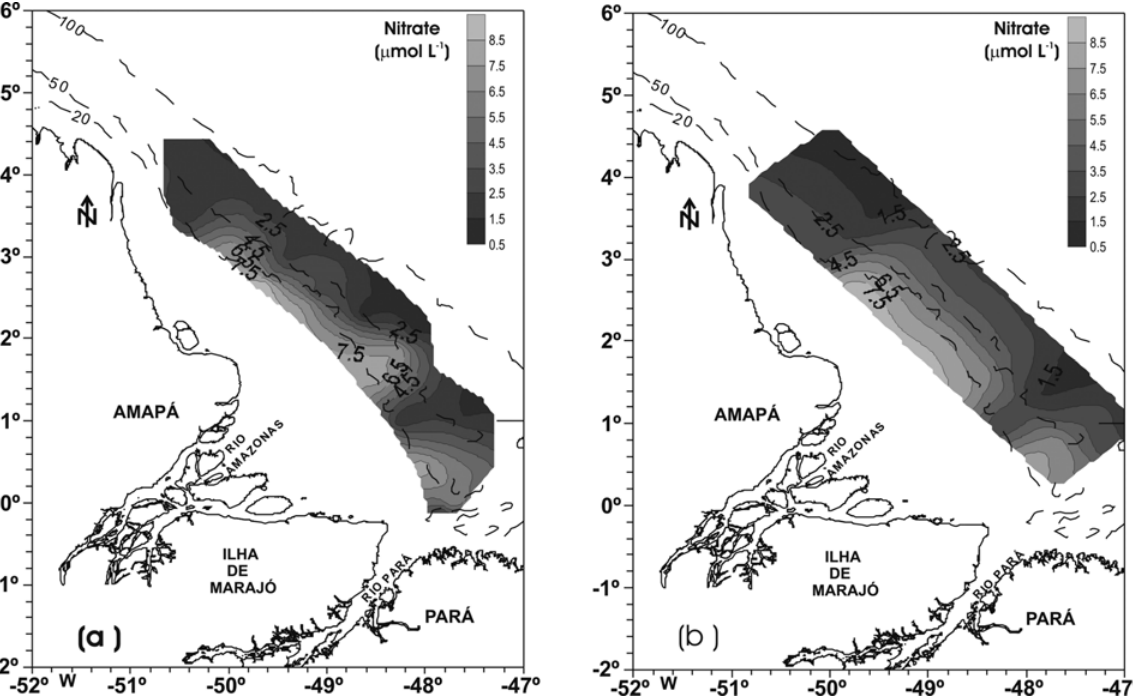
Fig. 10 – Distribution of the superficial concentration of the nitrate during Operation Norte III (high discharge of the Amazon river): (a) REVIZEE data; and (b) MACC-2D model